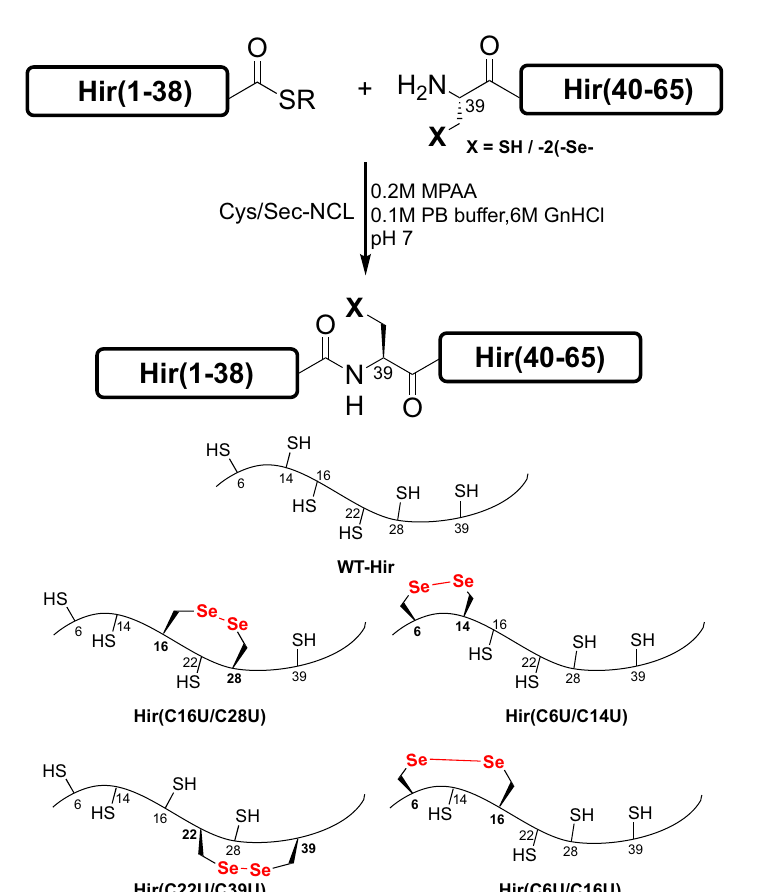
Fig. 2 Chemical synthesis of WT-Hir and its seleno-analogues. The WT-Hir, Hir(C6U/C14U), Hir(C16U/C28U), Hir(C22U/C39U) and Hir(C6U/C16U) have been produced by native chemical ligation (NCL) reactions. The amino acid sequence of WT-Hir is also shown. The ligation site is indicated in bold/ underlined letters, while the Cys residues are marked in